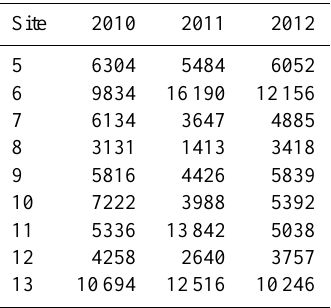
Table 8. Seasonal pollen indices for the Swiss observational sites for the years 2010 to